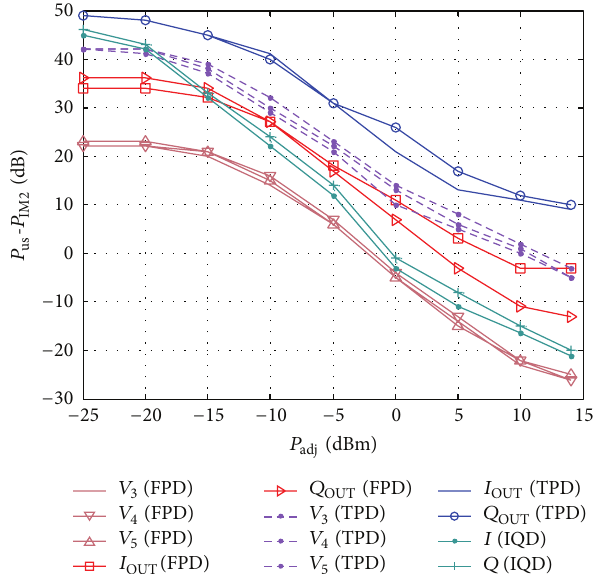
Figure 8: Measured IMD2 products suppression performance of two interfering signals around versus adjacent channel power 𝑃 adj 2.8 GHzforFPDandTPDandattheoutputsofthe 𝐼/𝑄 regeneration = 5 dBm and 𝑃 = −35 dBm) connected to both circuit ( 𝑃 LO RF architectures.